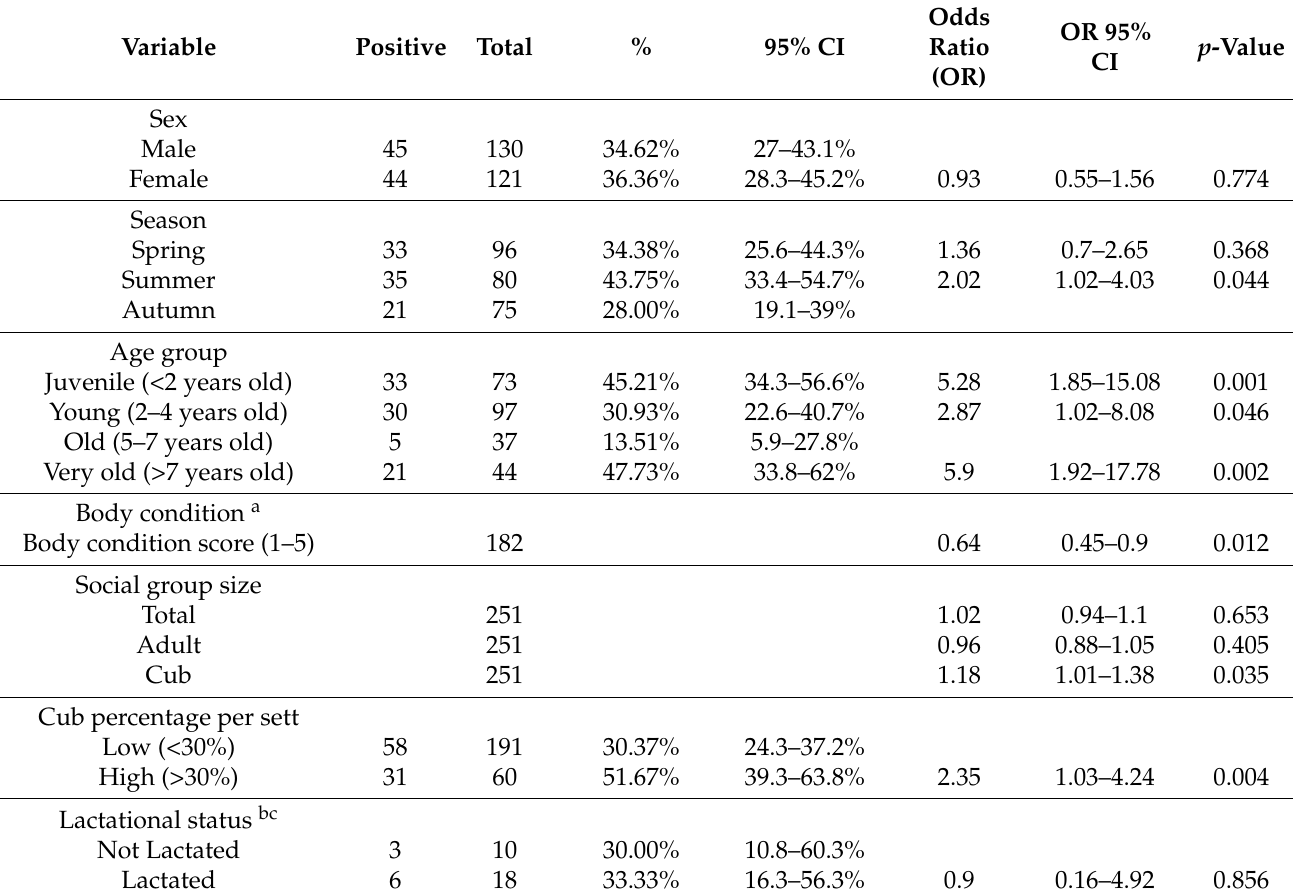
Table 2. Overview of MusGHV-1 DNA detection rate in badger genital tract and univariate logistic regression